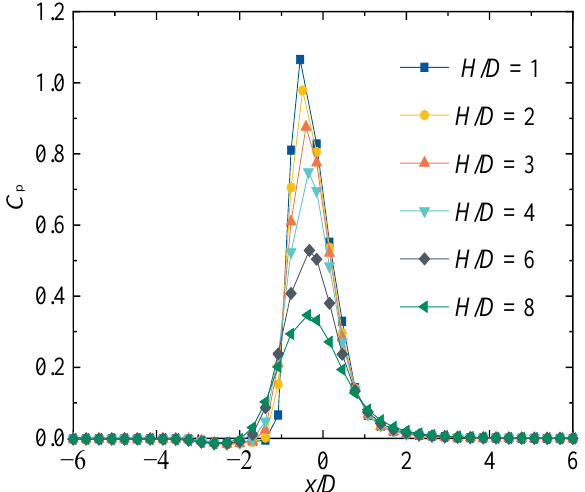
Figure 18. Variation of pressure coefficient C p along the x -axis at various impinging heights. Oblique submerged impinging jets ( θ = 45 ◦ ) at various heights (1 < H/D < 8) were obtained through the numerical simulation: the distance between stagnation point (SP) and geometric center (GC) increases gradually. at different locations of the wall-jet region is essentially consistent with the formula V m /V b = 2.3( x/D ) − 1 . As the impinging height increases, the size of the vortex in the flow field is almost unchanged, but its intensity gradually weakens. pressure coefficient and pressure coefficient, but the effective impinging pressure is main- tained in the range of − 2 ≤ x/D ≤ 2. The pressure distribution is similar at various heights, and the impinging pressure concentration on the left ( − x direction) of the maximum pressure point is